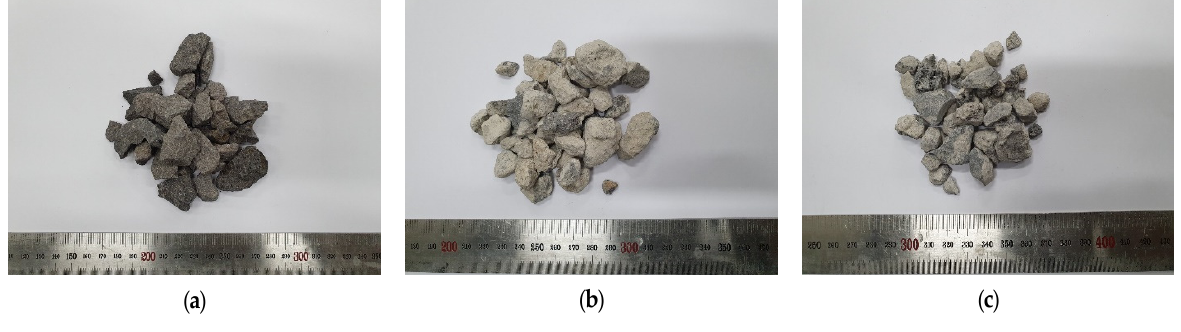
Figure 2. Coarse aggregates: ( a ) BA; ( b ) RRA; ( c ) PRA. Table 6. Physical properties of coarse aggregates.